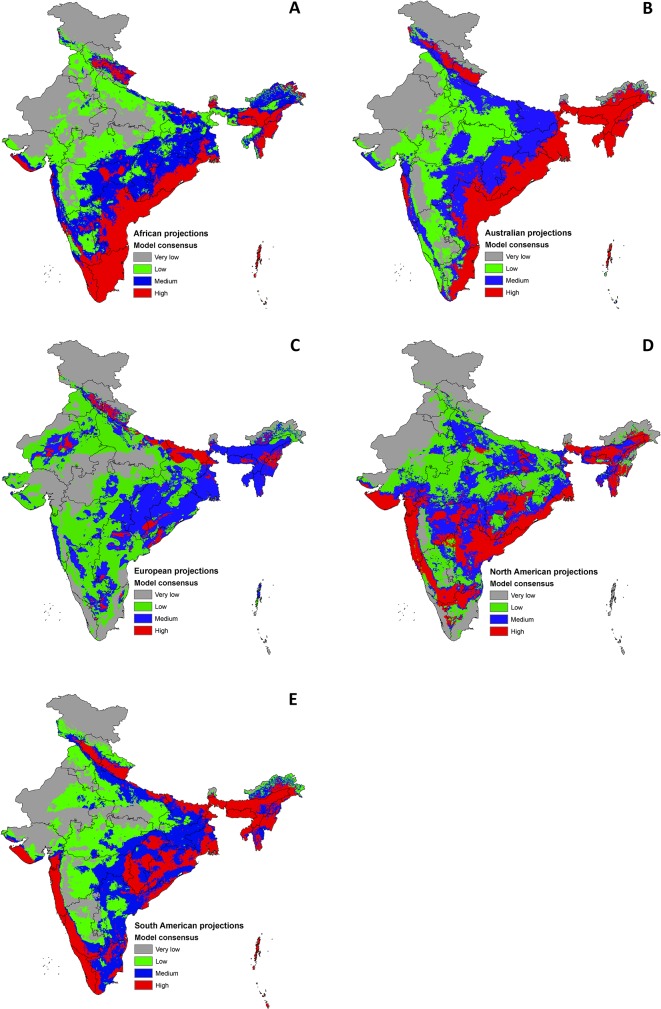
Climatic suitability map for diverse alien plant species in India based on continent of origin.A-E show the model consensus identified by summing up the thresholded model projections for multiple species from—(A) Africa, (B) Australia, (C) Europe, (D) North America, and (E) South America. The figure legend show the model agreements, wherein ‘high’ represents the areas with highest model agreement, and ‘very low’ having the lowest agreements. Higher model agreements represent larger number of alien invasive species while the lower model agreements represent lower number of alien invasives.